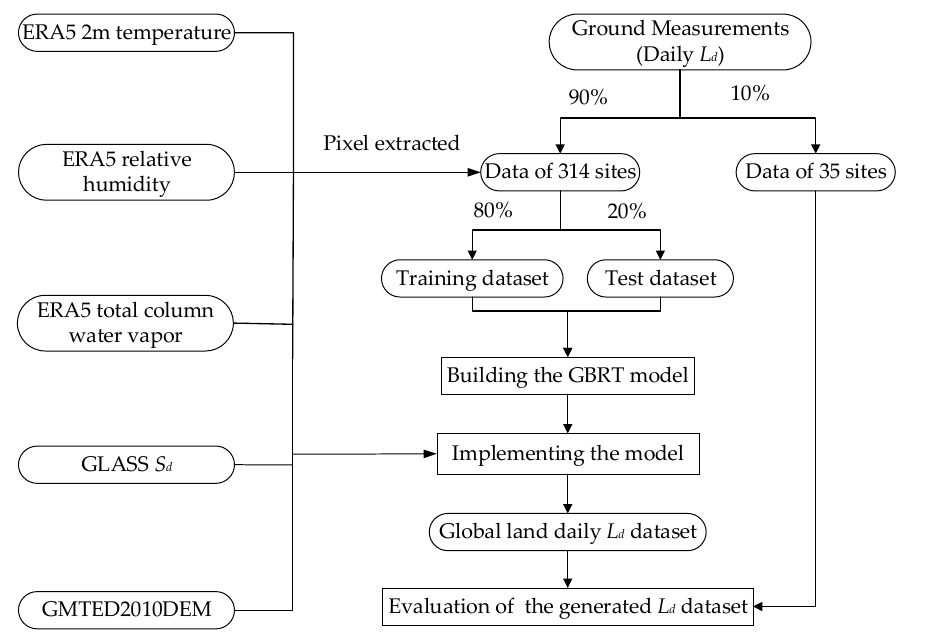
Figure 2. The main flowchart in this study.